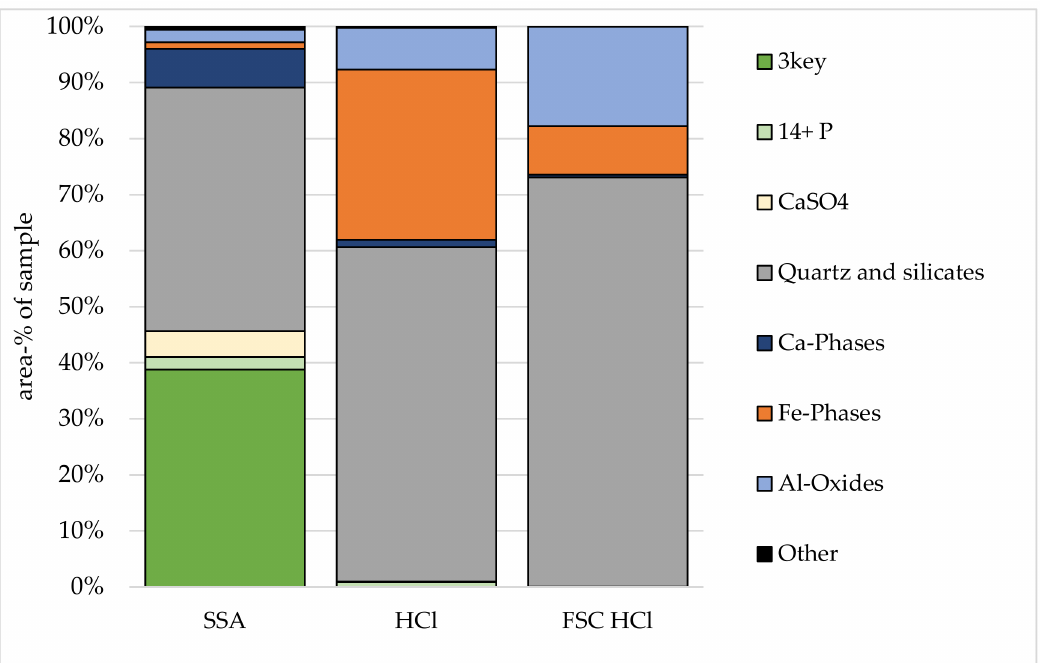
Figure 2. Composition of untreated SSA before and after chemical digestion by di ff erent acids (generic labelling); SSA: untreated, original sewage sludge ash, HCl: residue after SSA digestion with HCl; FSC-HCl: residue of HCl digestion of thermochemically treated SSA. Shares of material given in